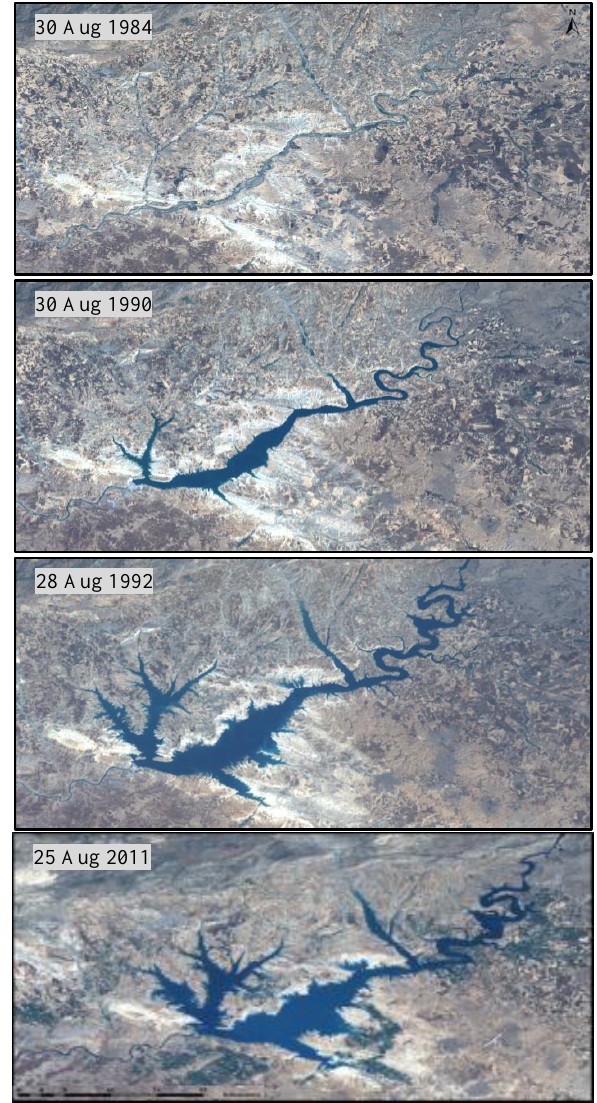
Fig. 4 Water reserve changes on the Atatürk Dam Lake between the years 1984 to 2011.